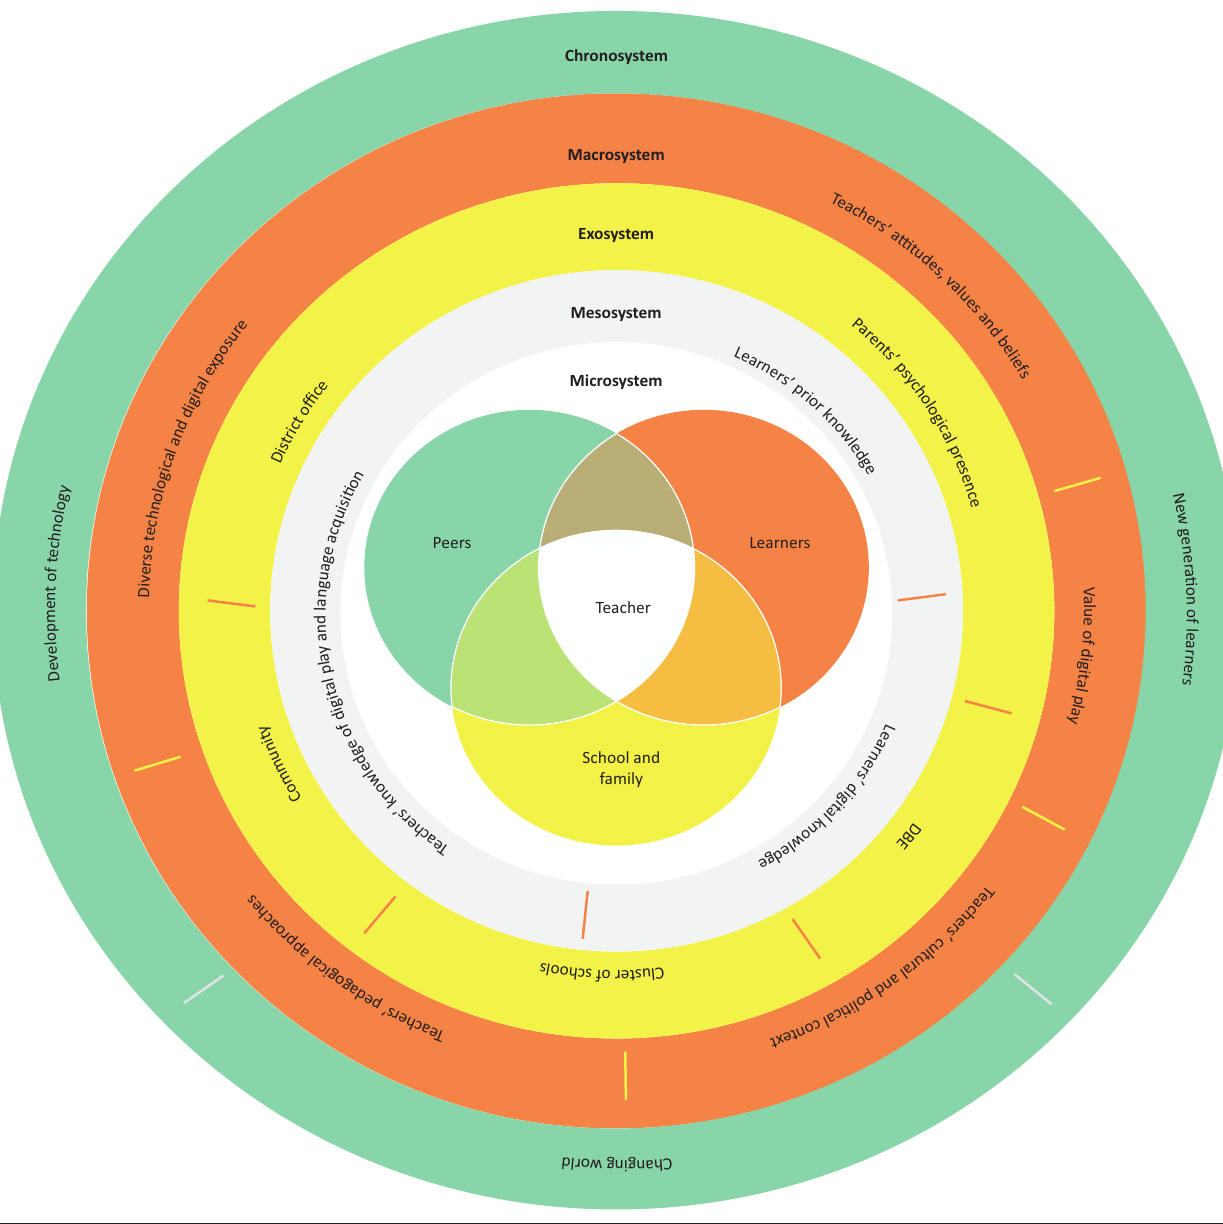
FIGURE 1: Key findings according to Bronfenbrenner’s ecological